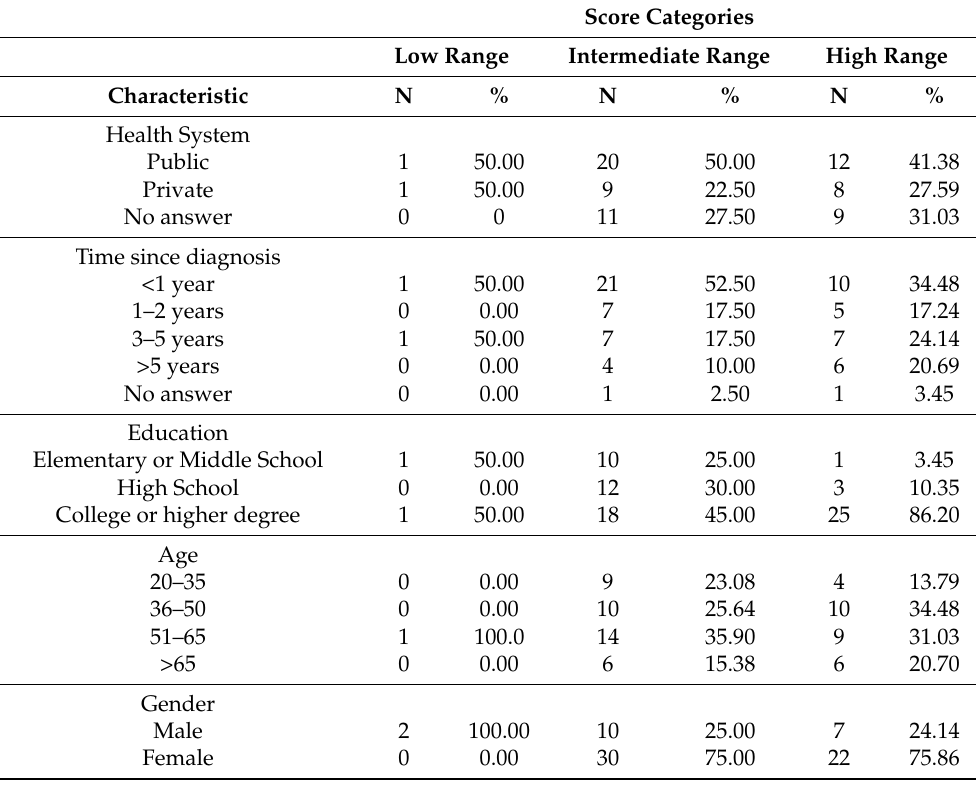
Table 4. Sociodemographic characteristics and score